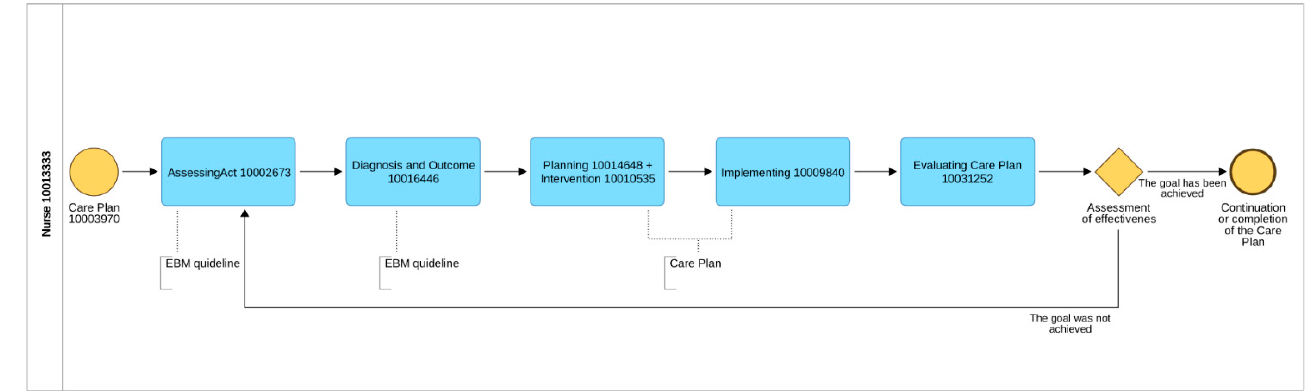
Figure 3. BPMN process of nursing care plan with using ICNP (compiled by Paulina Szydłowska– Pawlak, ADONIS, UMed.